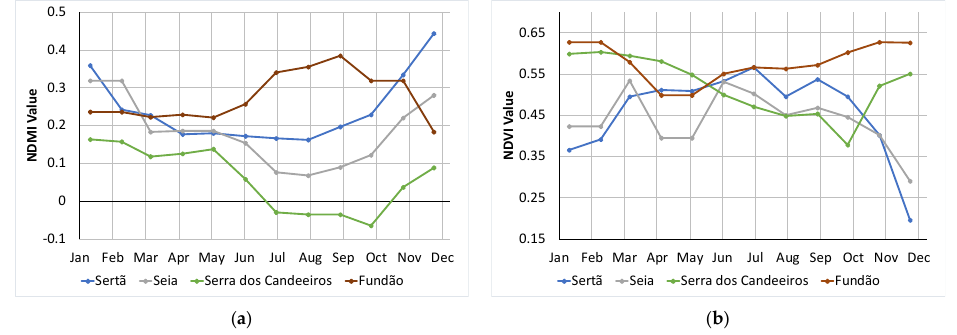
Figure 4. Spectral indices time-series from vegetation areas during 2017 for each study area. Here, both indices are strongly affected by phenology. ( a ) NDMI; ( b ) NDVI.